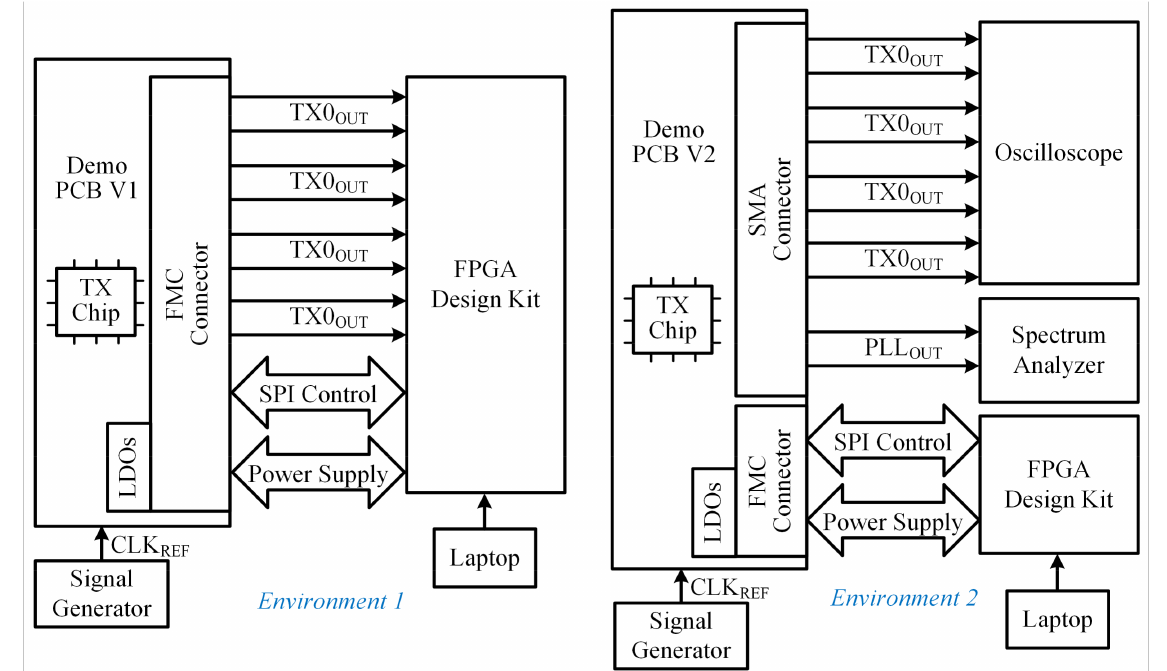
Figure 7. Measurement environment with the FPGA and the oscilloscope. In measurement environment 1, the FPGA design kit receives the four-lane differential data signal and checks the TX data with the specified PRBS patterns. The four-lane data were all checked, and the received data were correct, and the BER was less than 1e-10 up to 25 Gb/s data rate, which proved that the TX data were correctly serialized and the delay mismatch between each lane would not influence the chip function. The oscilloscope was adopted in measurement environment2 to observe the eye diagram and to confirm the high-frequency performance of the proposed TX chip. Figure 9 summarizes the measured eye diagrams of the TX lane-0; the TX can realize an eye height of >0.9 V ppd and eye width of >0.72 UI under different data rates, such as 1.55, 10, 28, and 32 Gb/s. As shown in Figure 10, the four TX lanes can achieve consistent performance. Figure 11a displays the measured s-parameter curves of the 0.5-m, 2.2-m, and 3.2-m paired cables. Figure 11b shows the eye diagrams before and after applying the equalization at a data rate of 32 Gb/s. It can be observed that the designed 3-tap FFE can optimize the eye-opening for all cable channels with − 4.1/ − 6.6/ − 9.7-dB